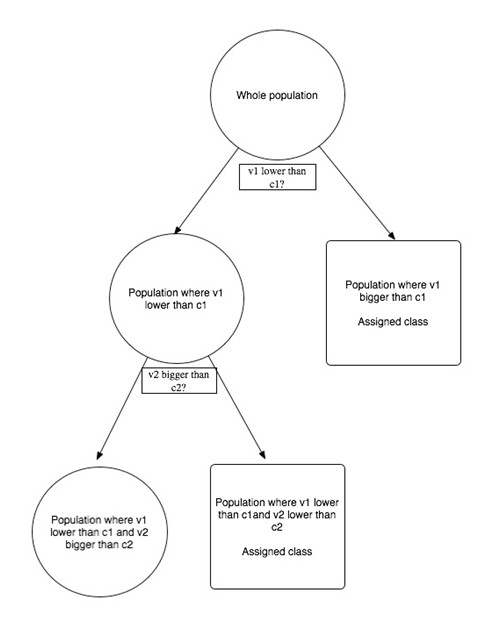
Classic structure of a CART tree. The first node of the tree is subdivided into two finer nodes depending on whether v1 is lower than c1. The resulting nodes are further subdivided to determine the assigned class.